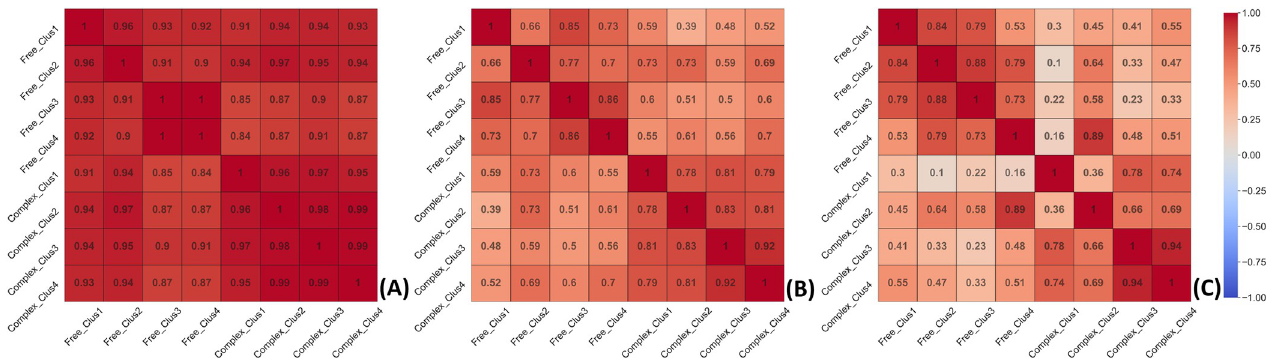
Fig 3. Heatmaps showing the relative similarities among various clusters of free and bound forms of CRTH: (A) SASA; (B) RMSF of CRD and (C) RMSF of conserved residues.